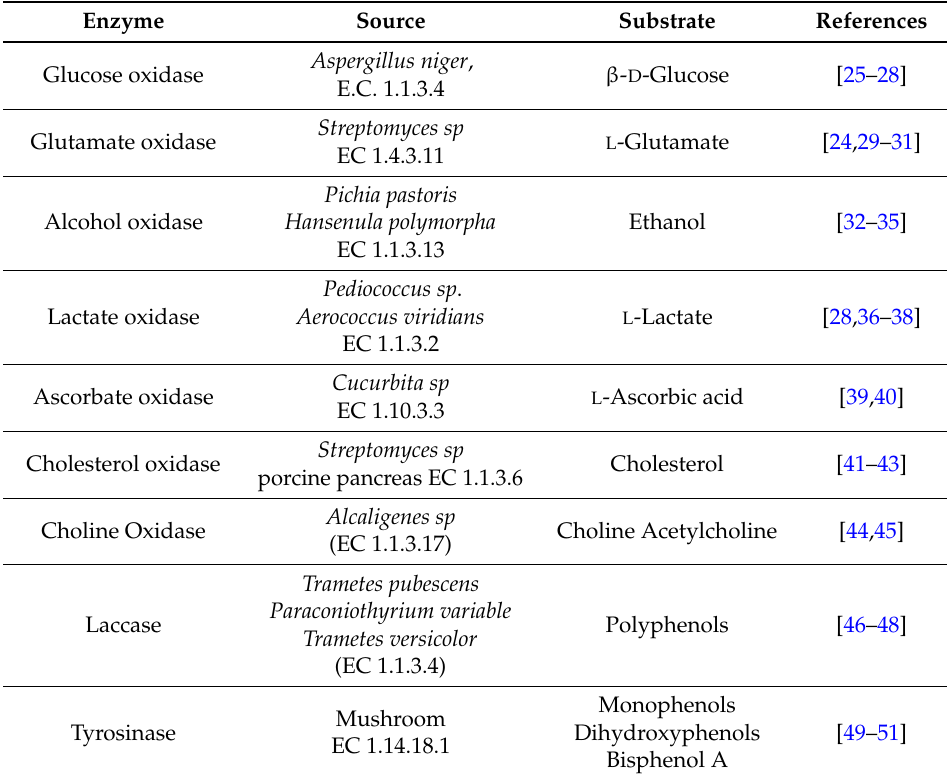
Table 1. Examples of oxidase enzymes used in amperometric biosensors.